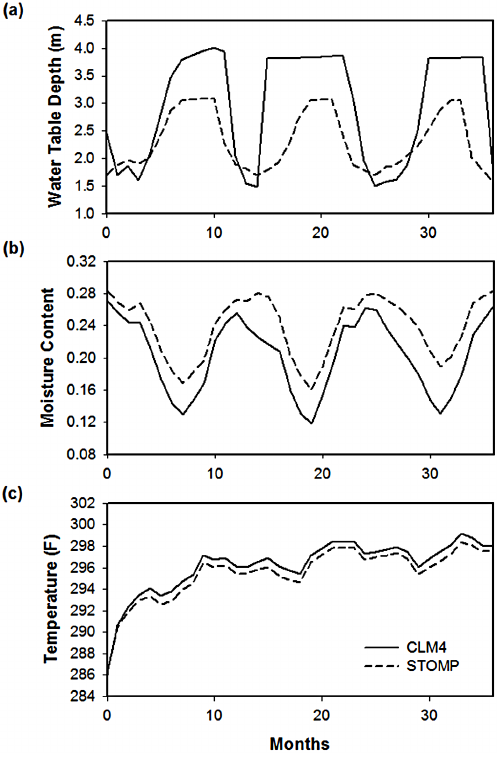
Figure 4. Annual average total soil C with respect to time at sites RJA, US-IB1 and US-SO2.